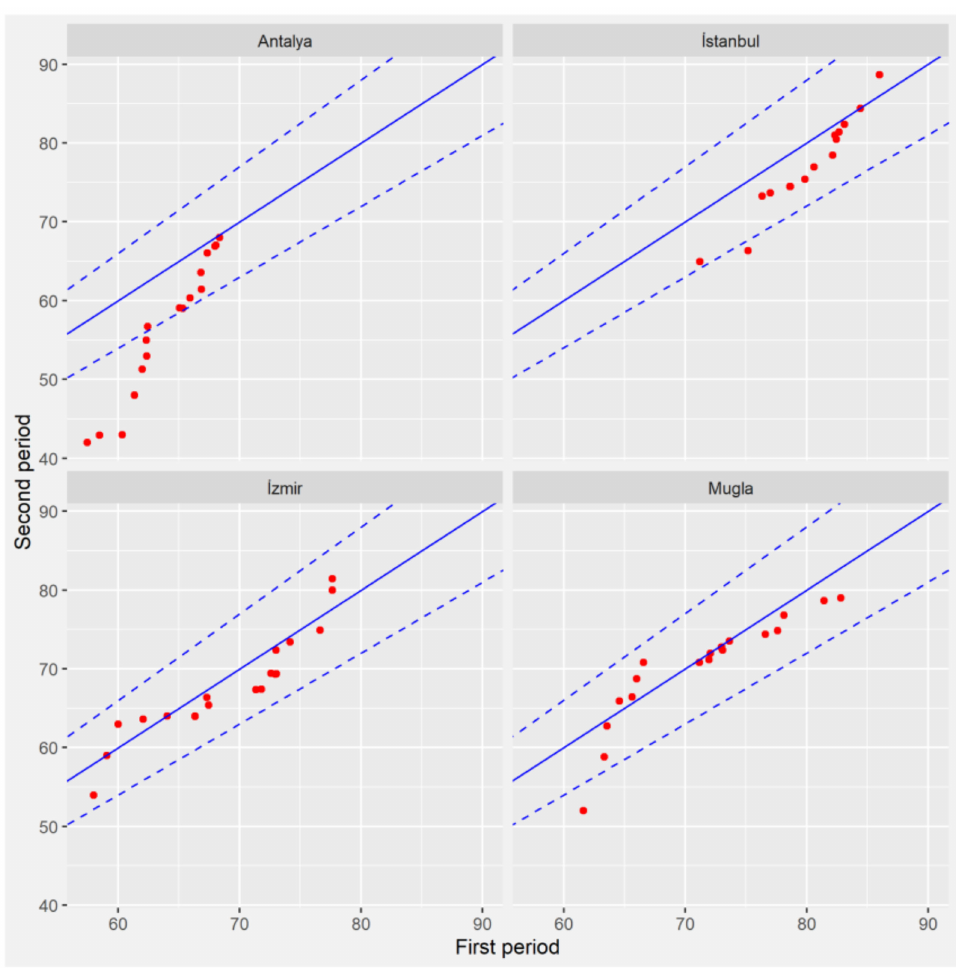
Figure 13. Sen trend analysis of TCI of